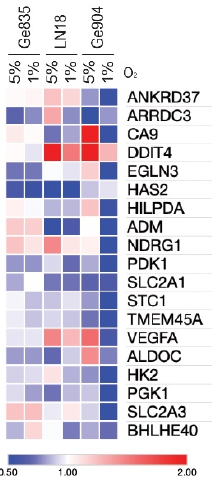
Figure 5. Metformin modulation of the upregulated genes of our hypoxia gene signature. Heat map represents fold-changes of expression between metformin-treated (10 mM, 48 h) versus vehicle-treated cells (red, FC > 2; blue, FC < 0.5). mRNA expression measured by qPCR of upregulated genes from the hypoxia gene signature on Ge835, LN18, and Ge904 treated with metformin or vehicle and exposed to physioxia or hypoxia. Fold change values are tabulated in Table S2.